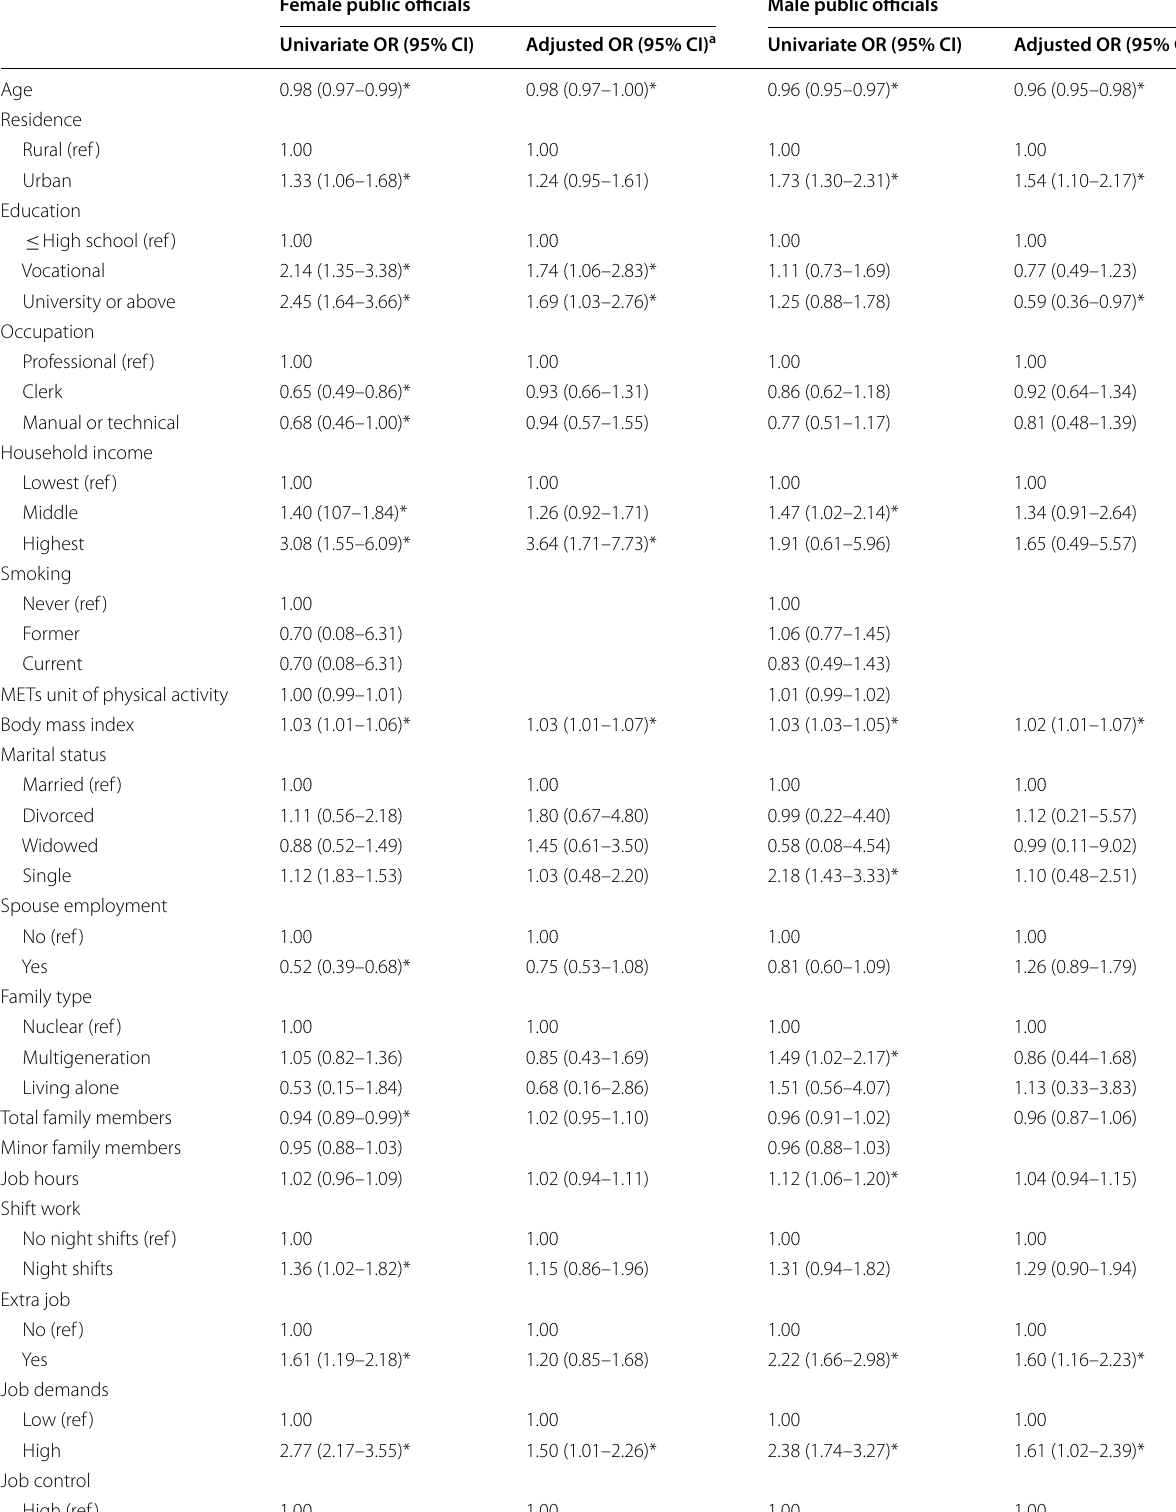
Table 3 Factors responsible for sleep disorders among Egyptian female and male public officials in a logistic regression